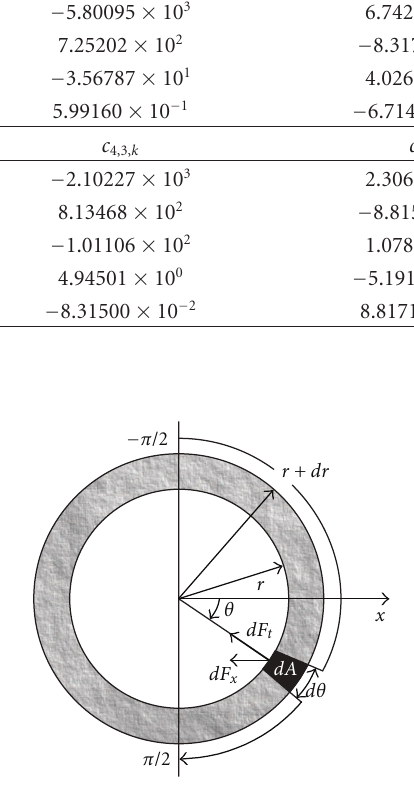
Figure 10: Di ff erential area ( dA = r d r d θ ) and x -component of tangential